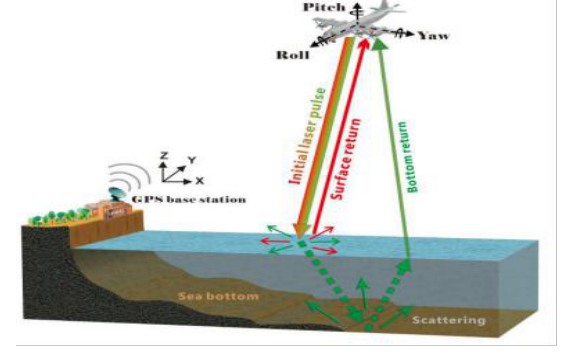
Figure1. Dual LiDAR working diagram